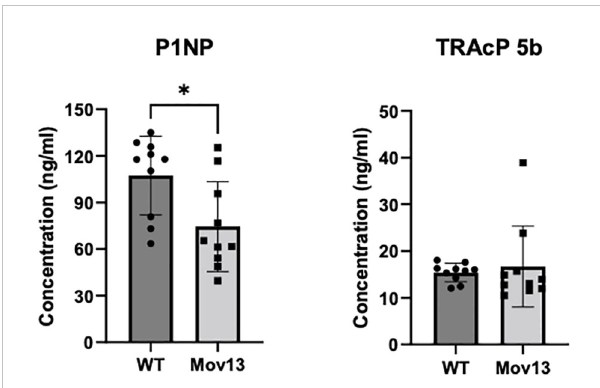
FIGURE 5 ELISA of bone turnover markers in serum. Markers for bone formation (P1NP) and bone resorption (TRAcP 5b) were measured in mice blood serum with ELISA. P1NP and TRAcP 5b measurement of eight-week-old Mov13 and WT littermates. Standard deviations (SD) are shown for each group: WT (n=10, 50%male) and Mov13 (n=10, 50%male). Statistical signi fi cance is indicated on the graphs (P- values ≤ 0.05 (*)). TRAcP 5b was measured with a non-parametric unpaired